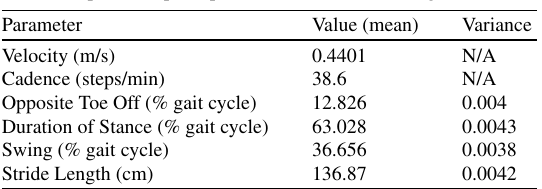
Table 2 Spatio-temporal parameters of the resultant